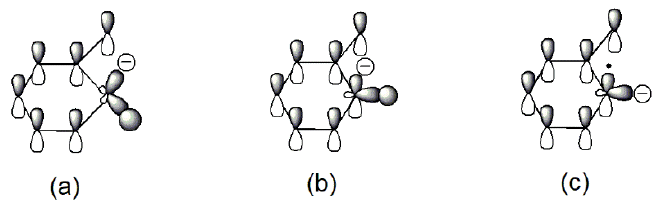
Figure 3. Illustrations of pi orbitals in keto form (A): ( a ) sp 3 carbanion; ( b ) sp 2 carbanion; and (B): ( c ) sp 2 radical anion.